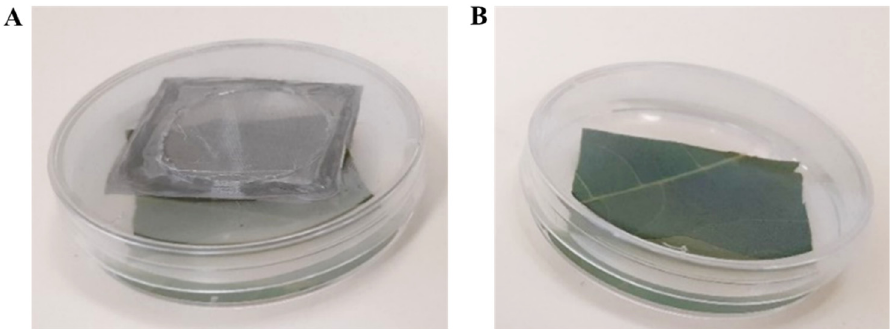
Figure 1. Set-up of an indirect inoculation system. Treated leaves were embedded in 2% agarose and allowed to cool and set. Plates were populated with larvae of Spodoptera littoralis and capped with perforated cap for low relative humidity (RH) condition ( A ) or unperforated cap for high RH condition ( B ).